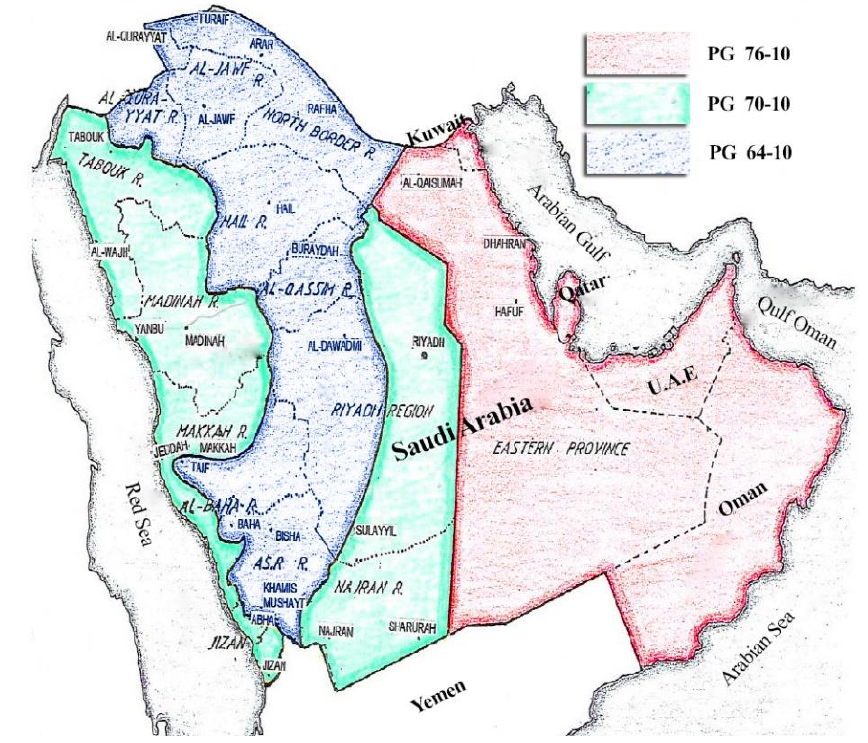
Figure 1. The temperature zoning for Gulf countries.